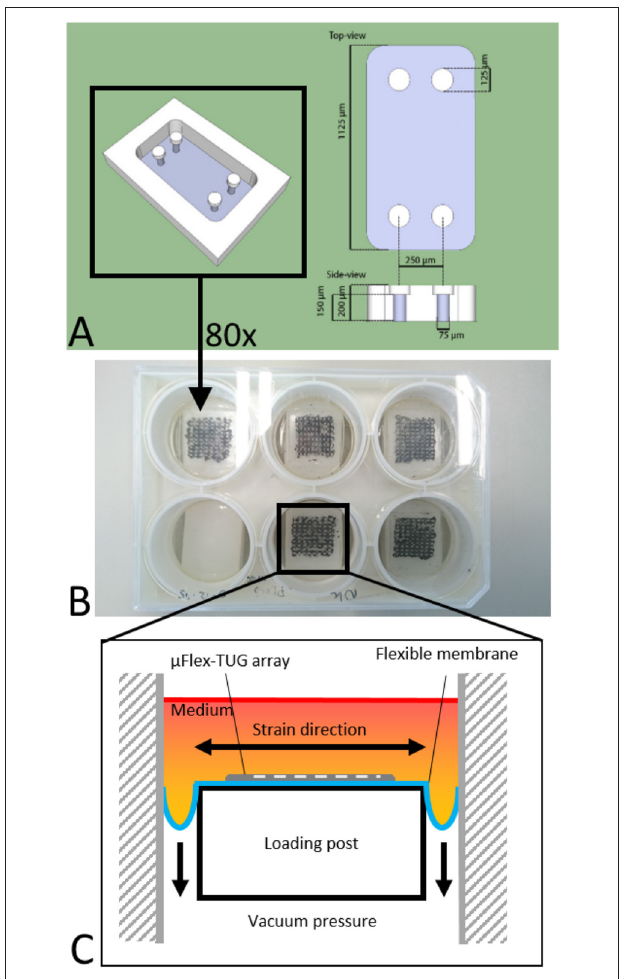
FIGURE 1 | (A) Design of the microwell containing four PDMS microposts (courtesy of Alex Bastiaens). (B) µ TUGs created on a Flexcell plate to create a µ Flex-TUG. (C) Application of uniaxial dynamic loading to the µ